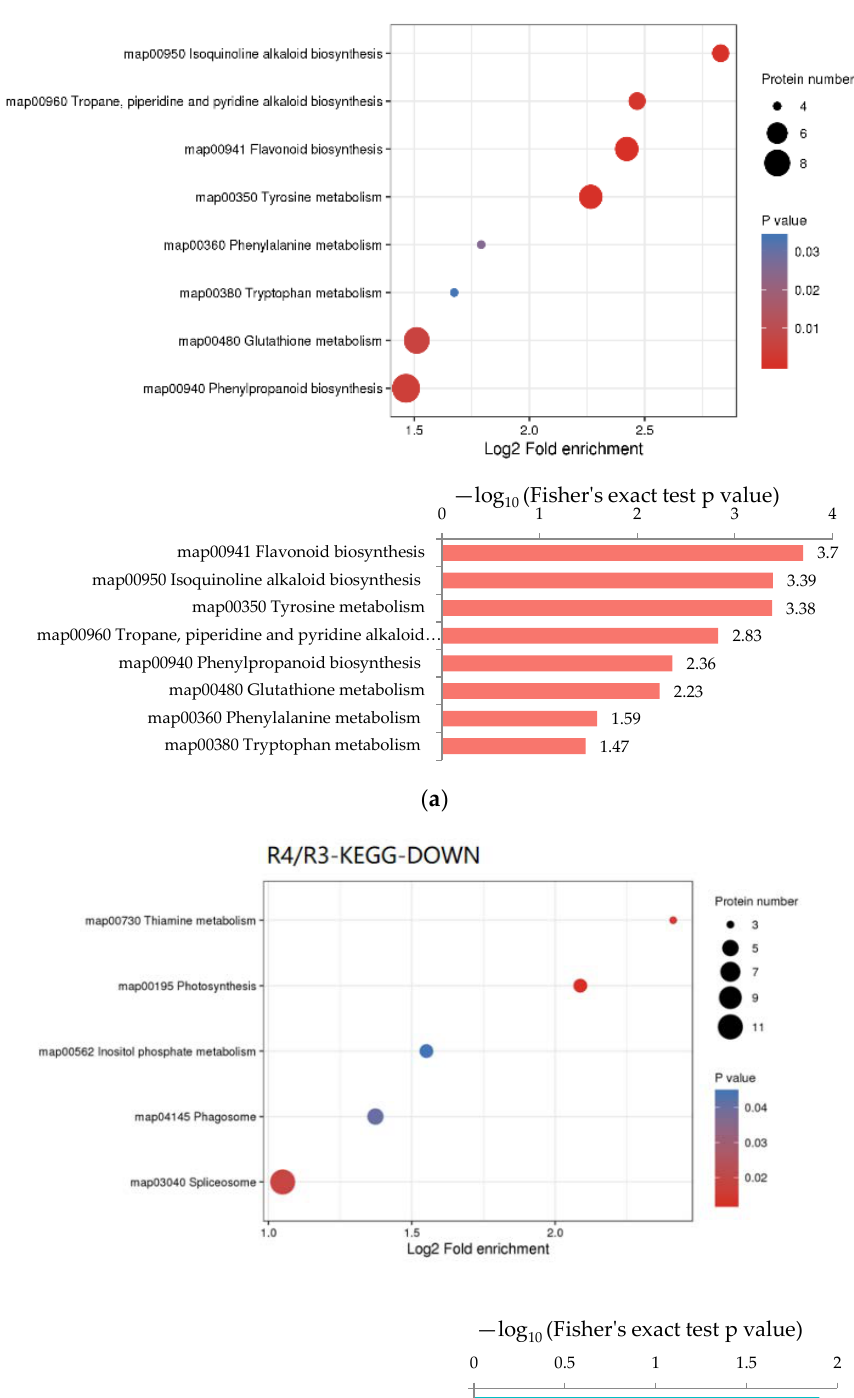
Figure 7. KEGG enrichment analysis of DEPs in R4/R3. In the bubble diagram, the redder the color, the more significant the enrichment of categories. ( a ) KEGG enrichment analysis of up-regulated DEPs in R4/R3. ( b ) KEGG enrichment analysis of down-regulated DEPs in